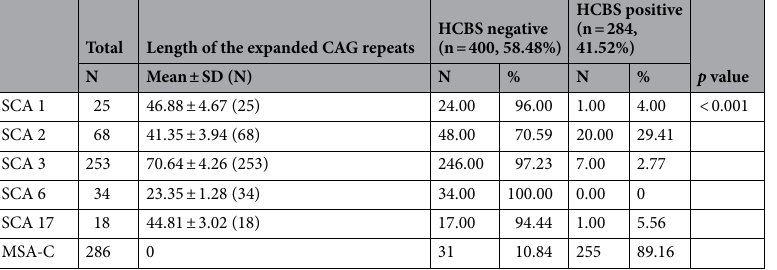
Table 2. The presence of HCBS in different subtypes of SCA and MSA-C. HCBS hot cross bun sign; MSA- C multiple system atrophy, cerebellar type; SCA spinocerebellar ataxia. Chi-square test. Numeric data are presented as mean ± standard